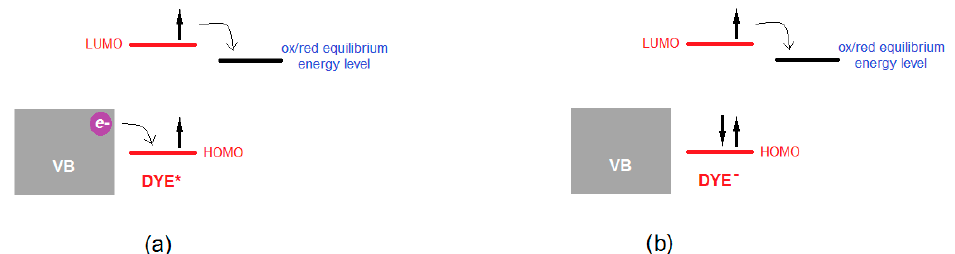
Figure 6. Mechanism of ET between the photoexcited dye sensitizer to the oxidized form of the redox mediator (with the redox energy level (in black) positioned below the LUMO of the dye ‐ sensitizer) in a p ‐ type sensitized cathode of a p ‐ DSC. The relative positioning of the frontier energy levels involved in the photoreduction process is shown. ( a ): case of ET from the excited dye to the redox shuttle which precedes hole injection in the semiconductor VB (charge injection slower than ET); ( b ): case of ET from the excited dye to the redox shuttle which follows hole injection in the VB of the semiconductor (ET slower than charge injection). HOMO ‐ LUMO energy separation for the immobilized sensitizer is assumed to be unvaried when the dye passes from the neutral state to ( a ) the oxidized or ( b ) the reduced state. In Equation (1) Φ inj , Φ esc and η tr represent the quantum yield of hole injection in the p ‐ type semiconducting electrode, the probability with which the injected hole does not get recombined, and the efficiency of charge collection at p ‐ type semiconductor/TCO interface, respectively. With the exception of the latter parameter η tr which depends basically on the intrinsic transport characteristics of the semiconductor, the first two terms Φ inj and Φ esc are directly related to the extent of surface area and express the probability that a hole photoinjected in the semiconducting electrode has to recombine either with the reduced dye, D − or with the reduced form of the redox pair, S − (Figure 6). These two events of (unwanted) recombination occur on semiconductor surface and have rates v rec1 and v rec2 defined as follows: